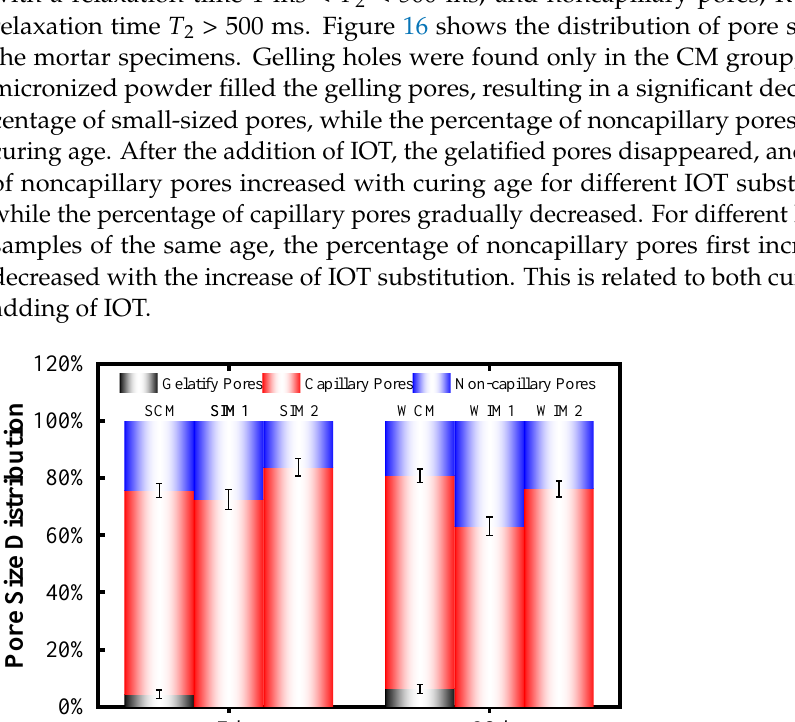
16 of 21 Table 7. Aperture distribution (unit: μ m). Group